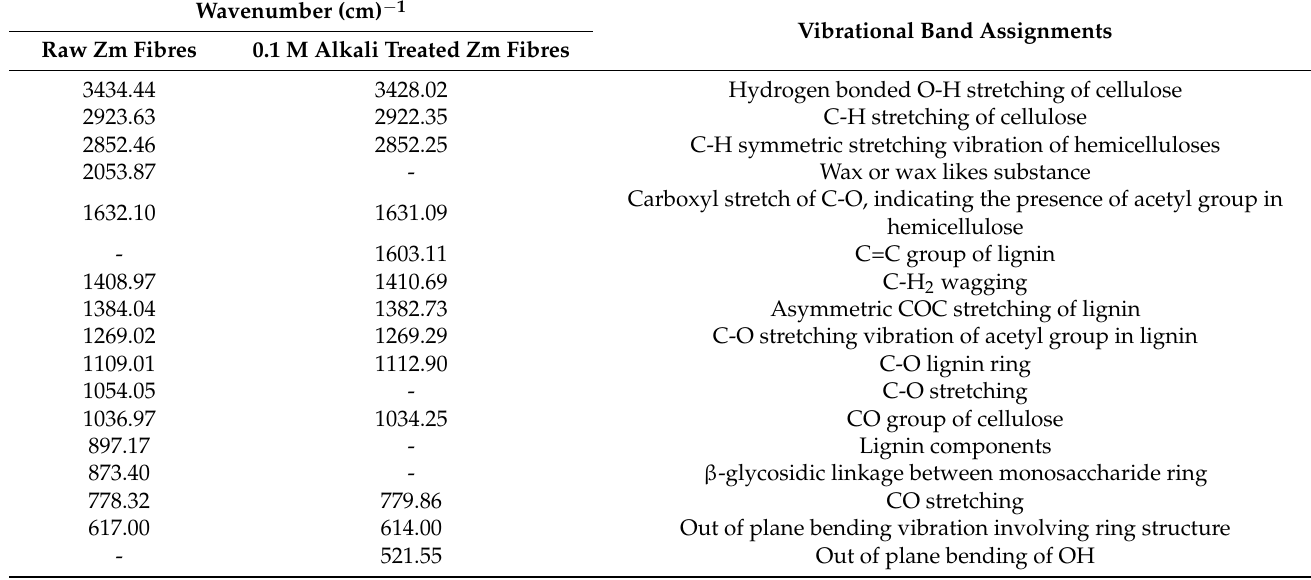
Table 4. FTIR Vibrational band assignment of raw and alkali treated Zm